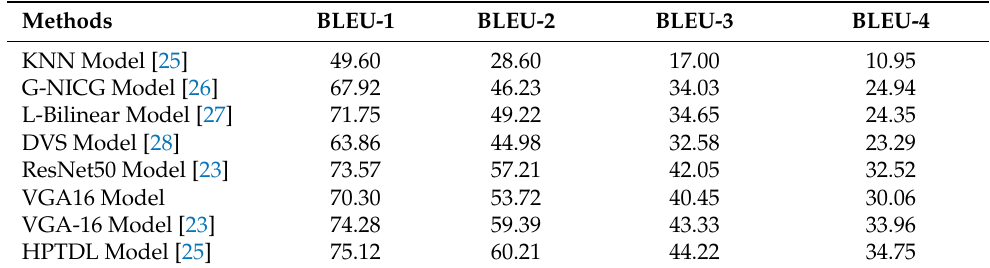
Figure 7. TL and VL analysis of MODLE-AICT technique on Flickr8K dataset. Table 4. Result analysis of MODLE-AICT algorithm with approaches on MS-COCO 2014 dataset.